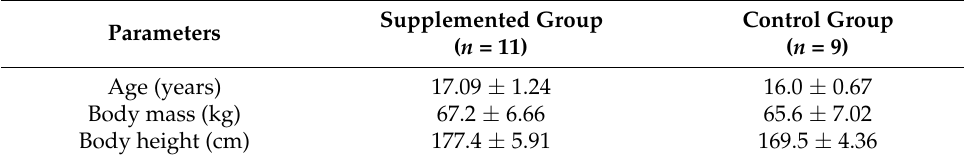
Table 2. Basic characteristics of the studied groups (mean ± standard